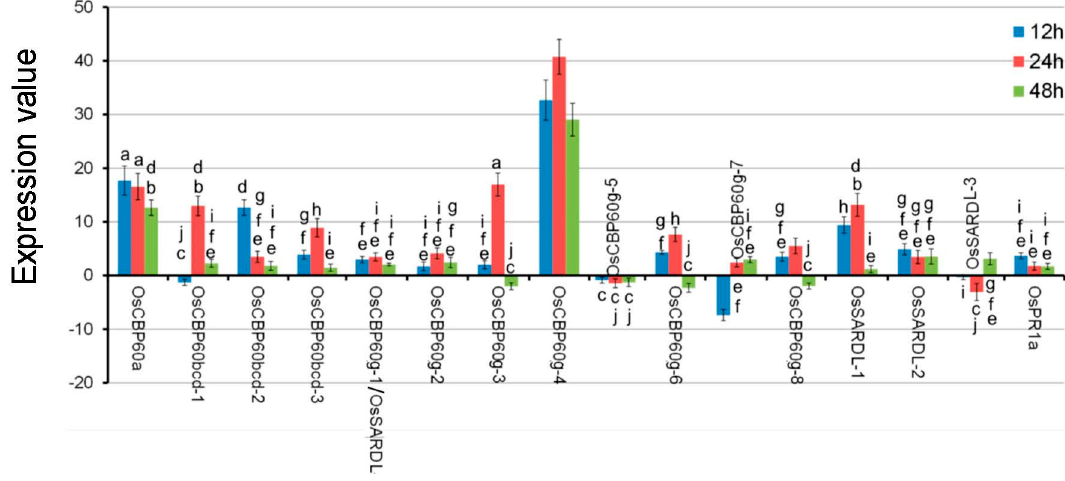
Figure 8. Transcriptional response of OsCBP60 genes in rice seedlings treated with salicylic acid (SA). Rice seedlings were treated with SA (3 mM sodium salicylate) and transcript levels were analyzed by qRT-PCR at 12, 24 and 48 h post treatment. Relative transcript abundance (expression value) is expressed as fold-change relative to the mock treatment. OsPR1a expression served as a positive control. Results are representative of three independent experiments. Error bars represent standard error (SE) of mean for three replicates. Superscripts with the same letter are not significantly different ( p < 0.05) by one-way ANOVA-protected LSD test.